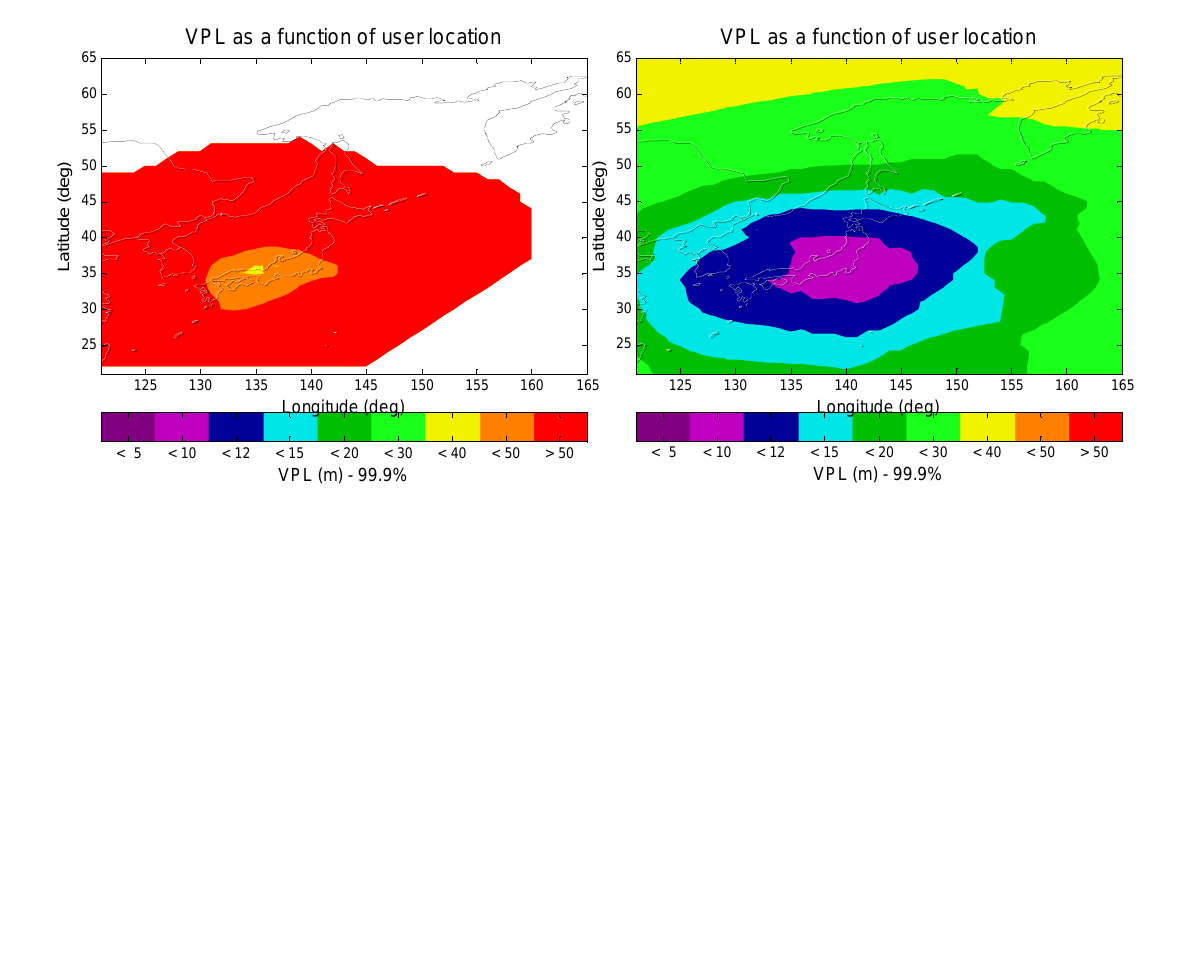
Figure 12. The 99.9% VPL contours of the MSAS user avionics sensor. The left figure is for the current MSAS user avionics sensor, and the right figure is for an L1-L5 dual-frequency MSAS avionics sensor with GPS and